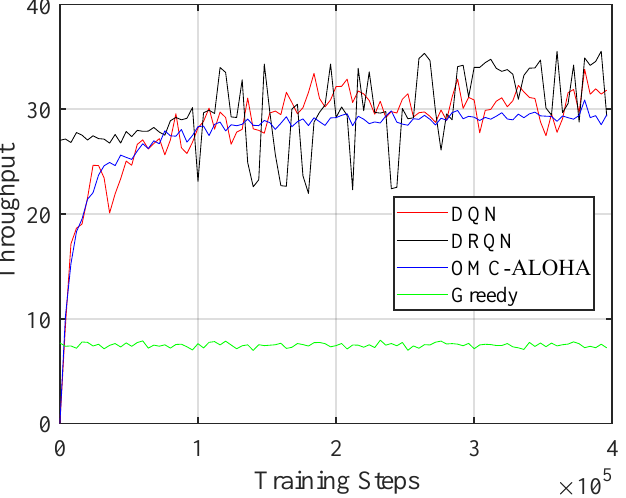
Figure 8. The throughput of the proposed method with different training steps (multiple